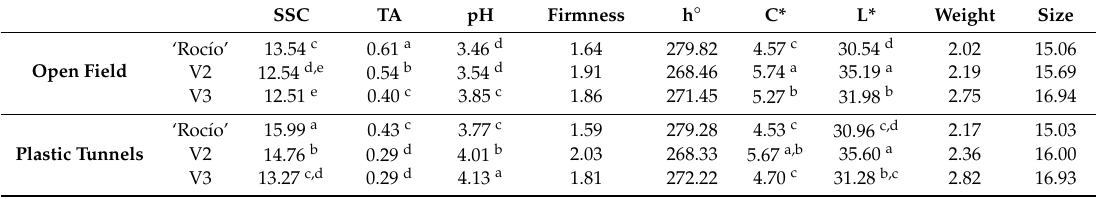
Table 3. E ff ects of cultivation system and genotype on the parameters evaluated for blueberry fruits. SSC TA pH Firmness h ◦ C* L* Weight Size ‘Roc í Open Field